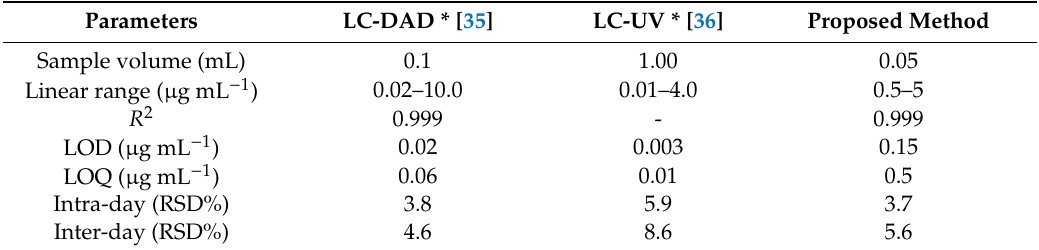
Table 4. Comparison of validation parameters methods for determination of TFV in plasma